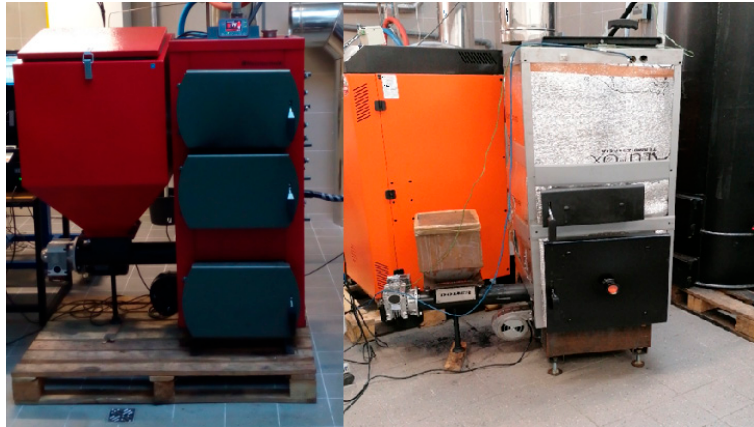
Figure 2. Heating devices used in tests. On left side: Q EKO 15; on righ t side: KN–20.